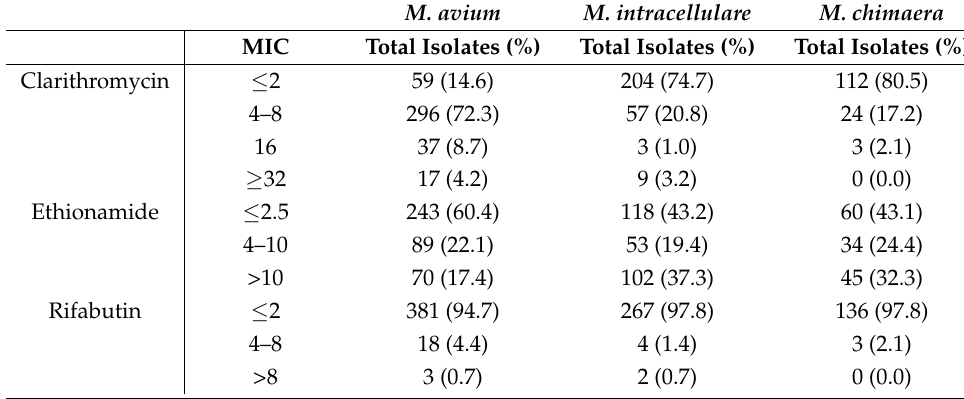
Table 2. Range of the distribution of the minimum inhibitory concentration results of M. avium , M. intracellulare , and M. chimaera versus 12